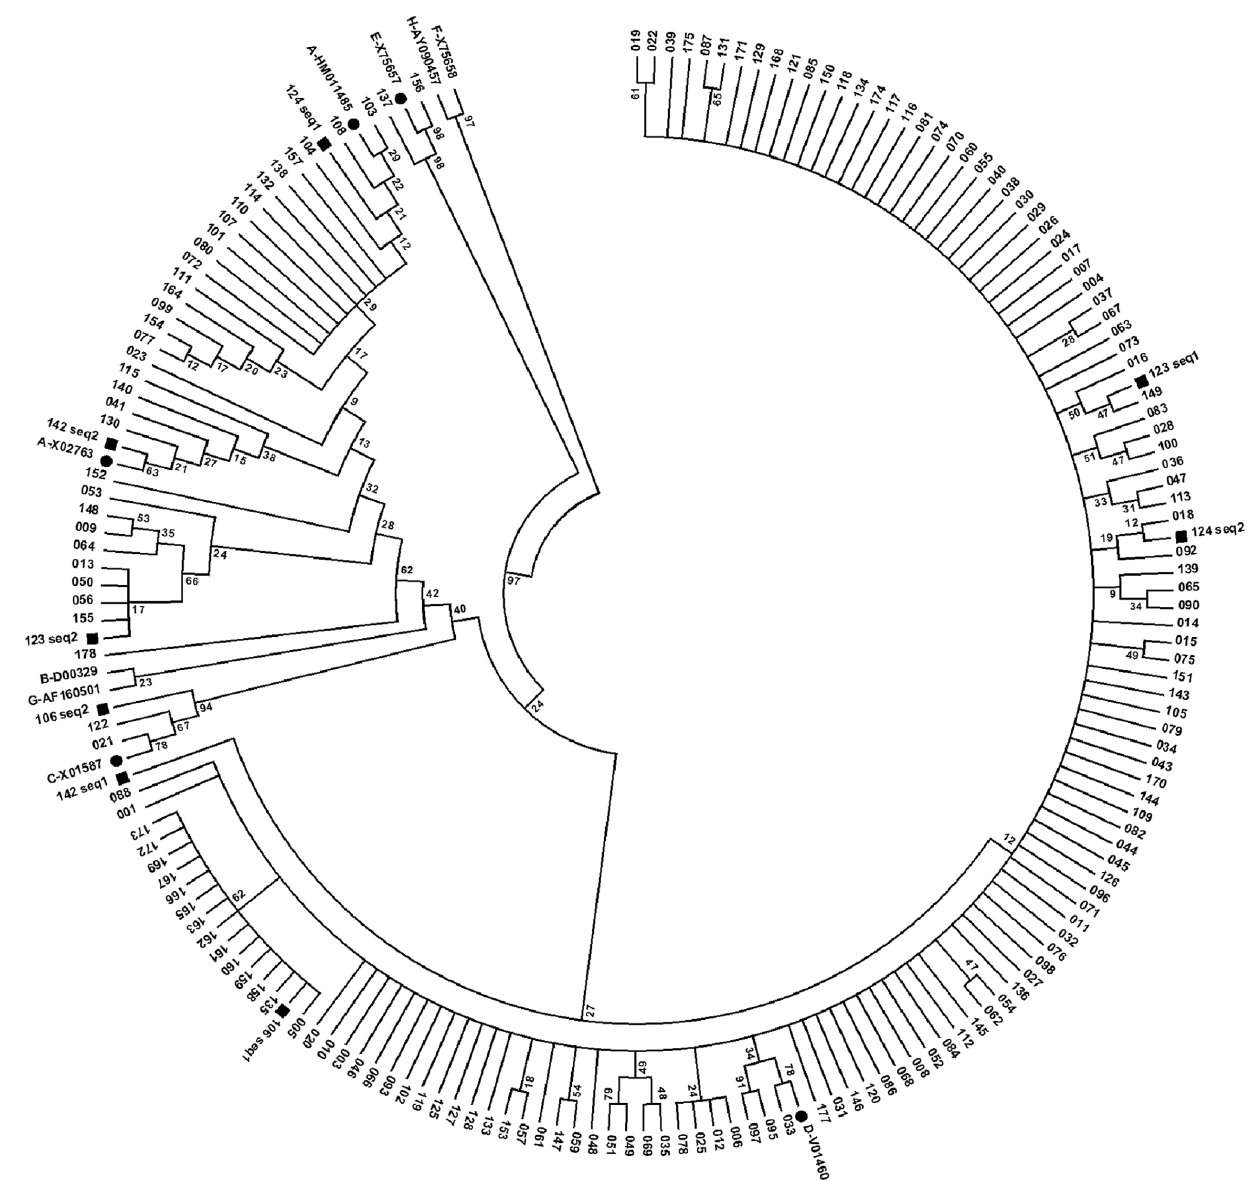
Figure 1. Phylogenetic analysis of Omani HBV strains. Phylogenetic analysis inferred from distance analysis (Kimura 2 parameters model) and N neighbor-joining reconstruction from a partially overlapping region of P and S genes (from nt479 to nt766) of 170 Omani HBV DNA-positive isolates. N ’’ signal with the GenBank accession number, respectively (for example: ‘‘A- The reference strains were denoted by HBV genotype and ‘‘ ’’). The Omani samples were numbered, and especially the double-infected samples were highlighted by the ‘‘ & ’’ signal. (The numbers HM011485 at the nodes indicate bootstrapping values.).